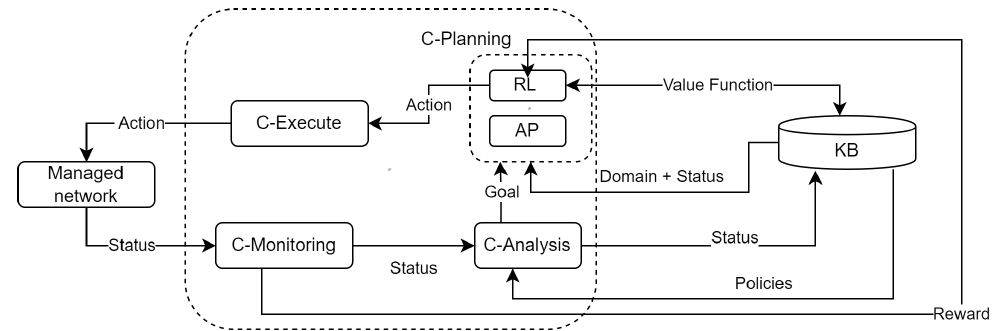
Figure 2. Automated Planning and Reinforcement Learning in the C-MAPE